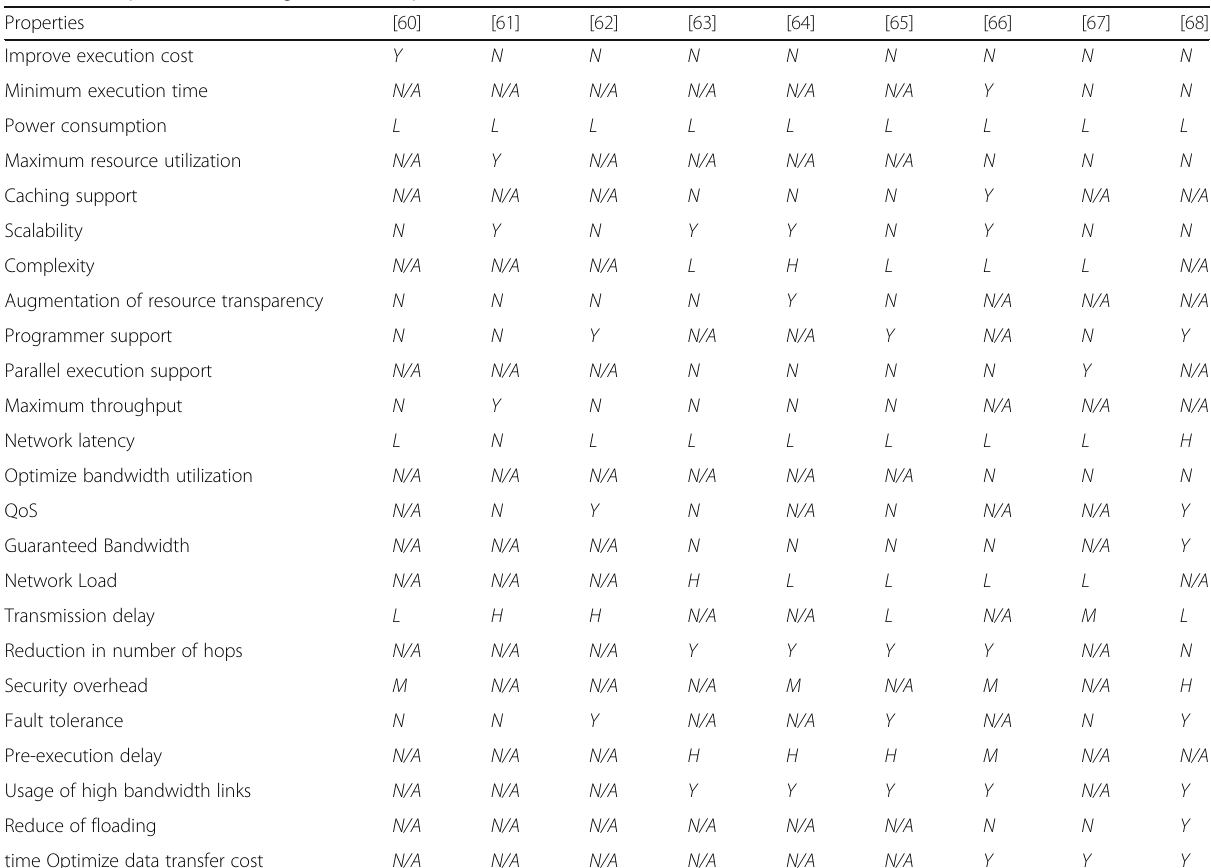
Table 2 Comparison of existing frameworks part-1